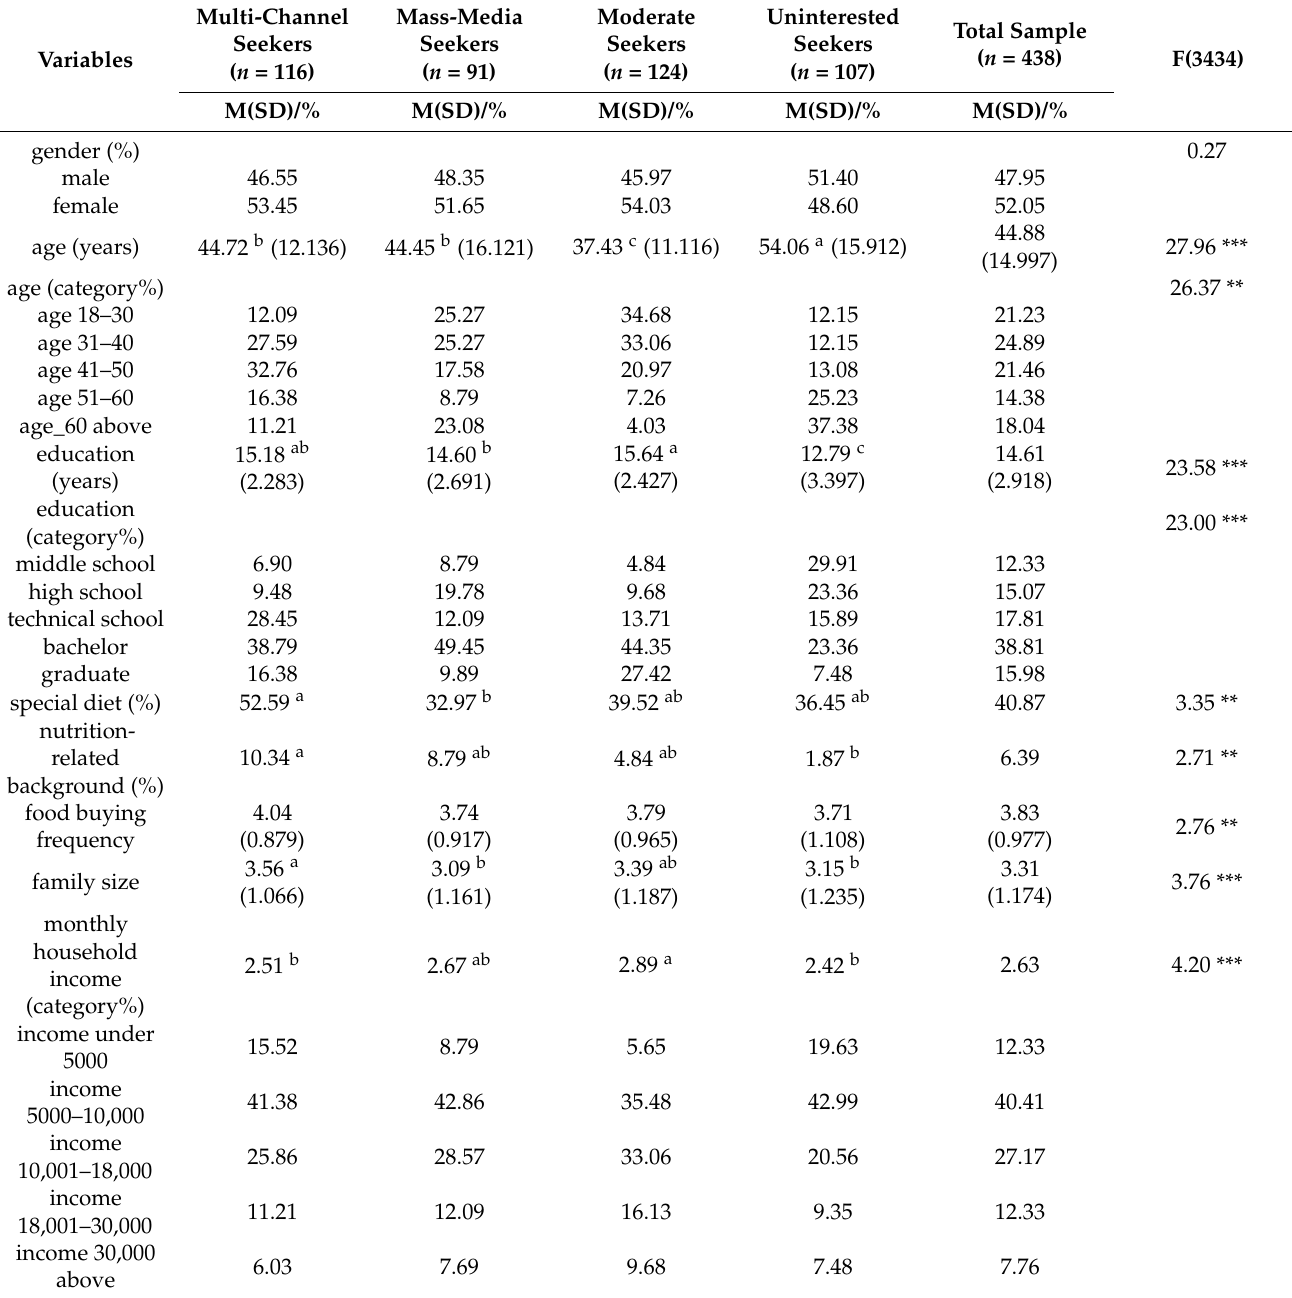
Table 3. Sociodemographic profiling of the